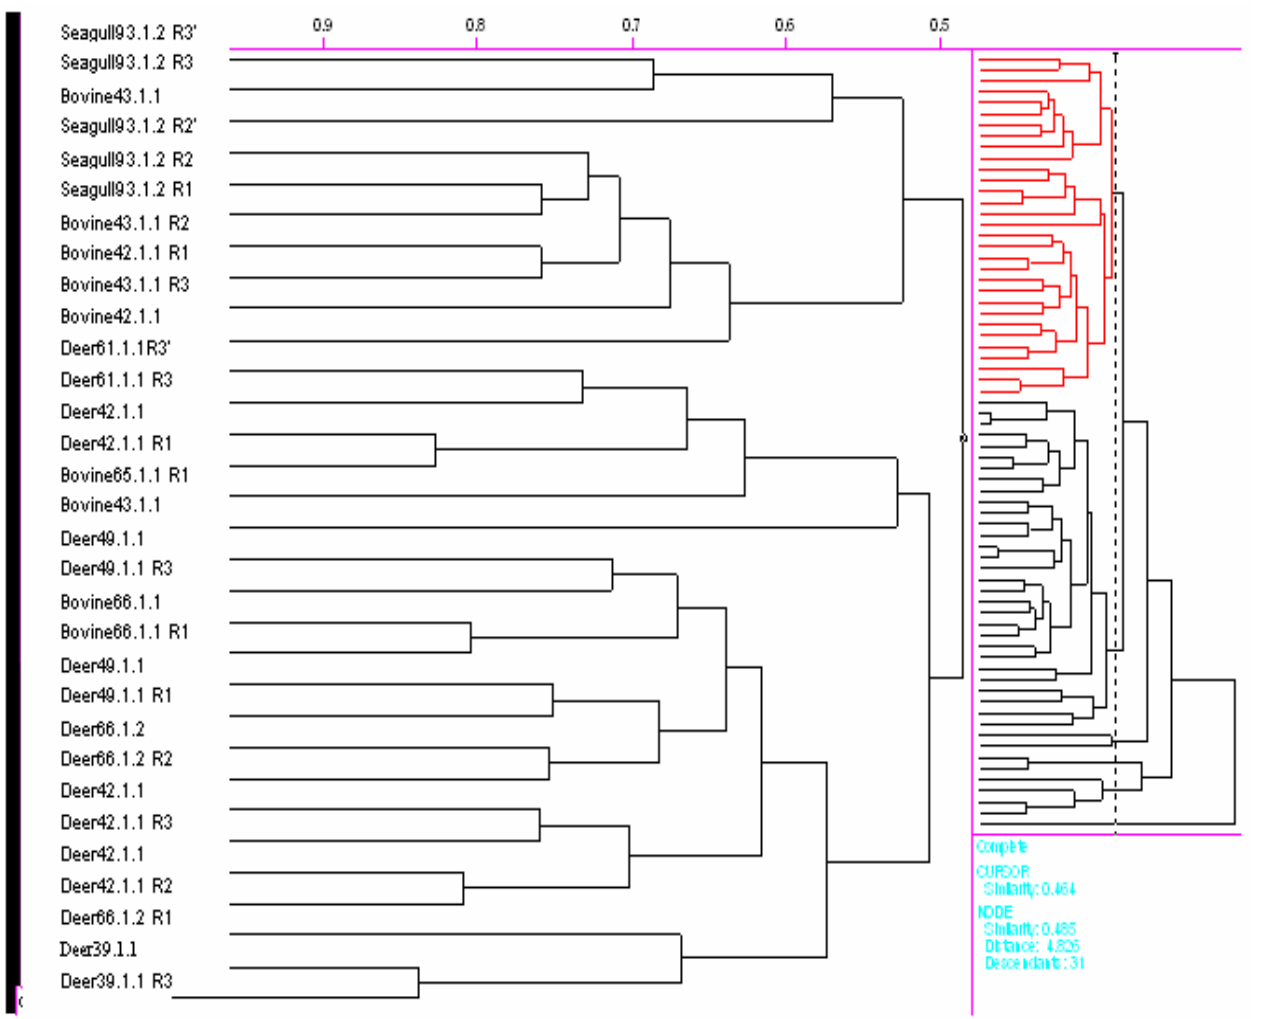
Figure 4: Hierarchical Cluster Analysis of normalized microarray spot intensities of replicates of 17 environmental isolates of Enterococcus sp . The dendrogram does not show good clustering by host origin at reasonable similarities. The bovine- origin replicates were most